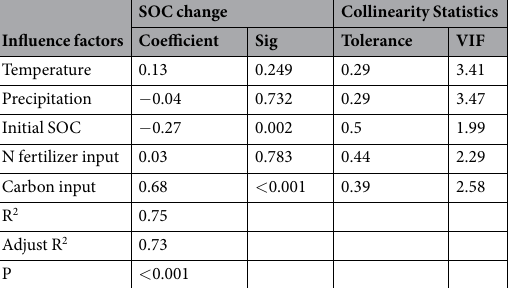
Table 4. Quantification the contribution of all drivers forces on SOC change ( n = 80). VIF, variance inflation factor. Sig, significant different ( P <